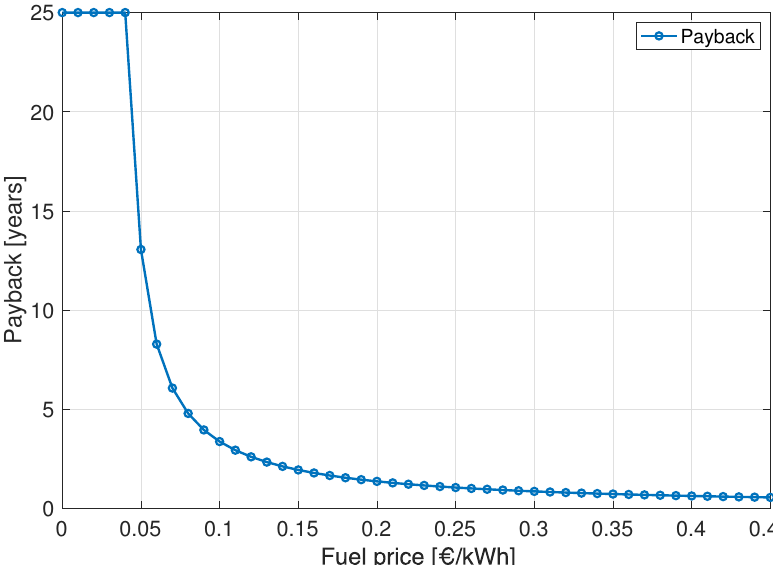
Figure 9. The discount payback period as a function of different fuel